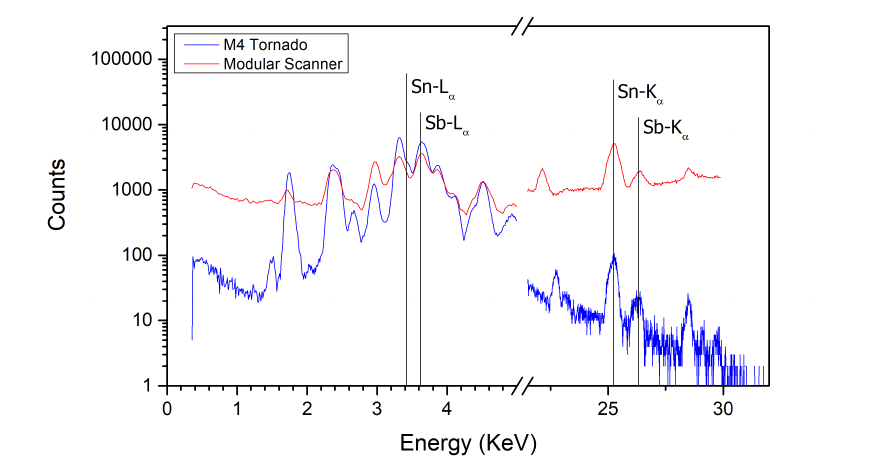
Figure 4. Sum spectra of the scanned